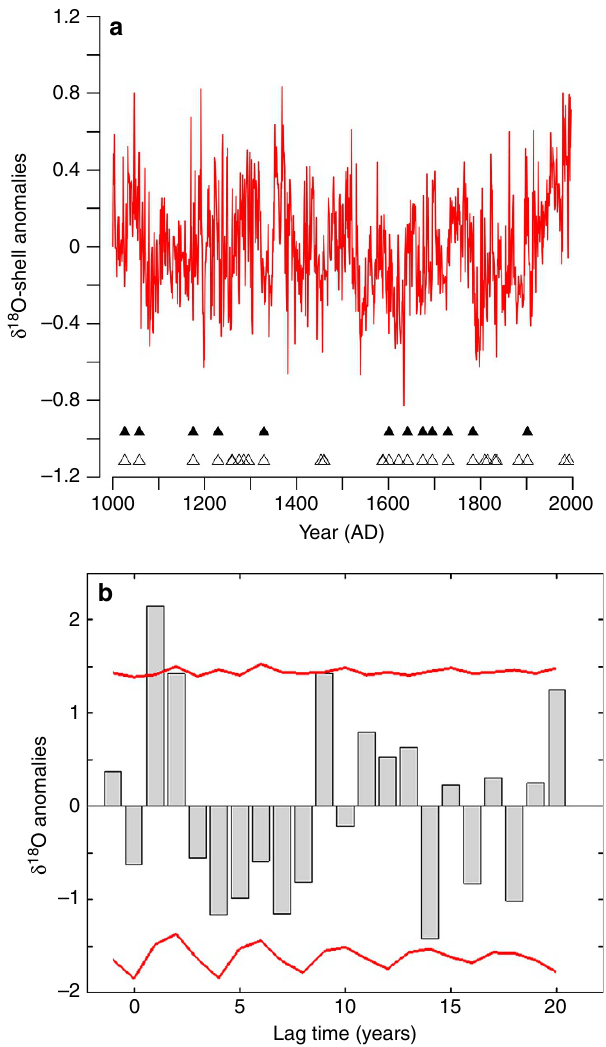
Figure 6 | SEA of the d 18 O-shell series. The SEA was conducted between the 12 largest volcanic eruptions of the last 1,000 years and the annually resolved d 18 O-shell series. ( a ) The annually resolved d 18 O-shell series (red line); the triangles indicate the timing of the 12 (black filled triangles) and 30 (open triangles) largest volcanic eruptions, respectively. ( b ) SEA analysis of the d 18 O-shell series using the 12 largest eruptions. The grey bars indicate the mean d 18 O-shell series anomalies in over the 12 analysis windows. The red lines indicate the 95% significance level derived using a bootstrapping